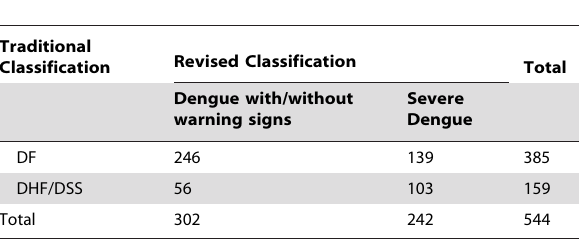
Table 3. Concordance a between Traditional and Revised WHO classification in capturing severe cases of dengue, 2005–